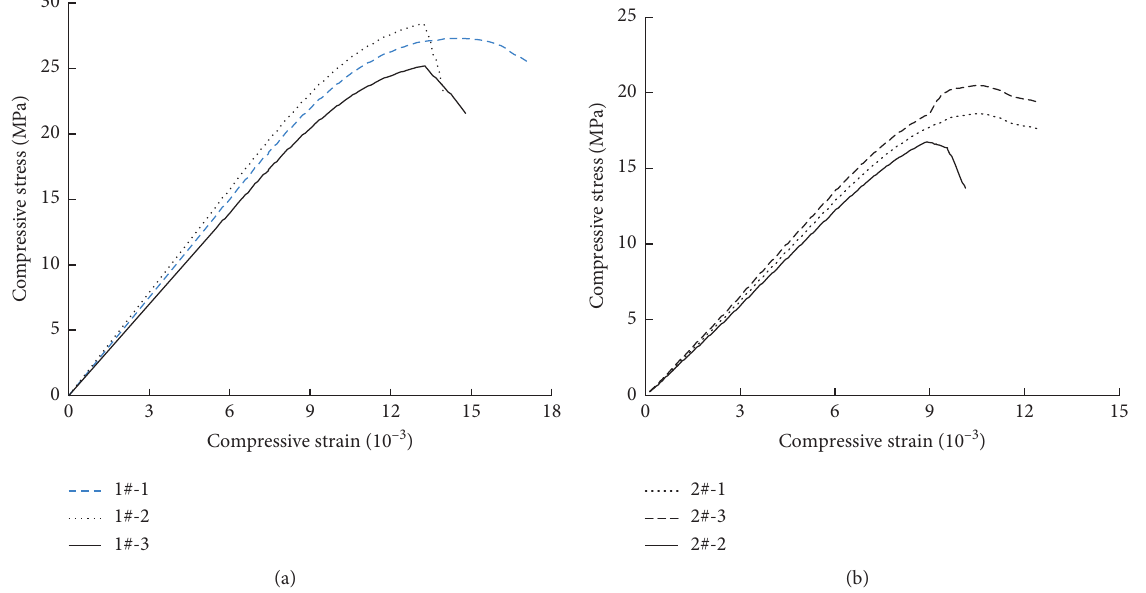
Figure 15: Compressive property of pervious concrete: (a) specimen 1#; (b) specimen